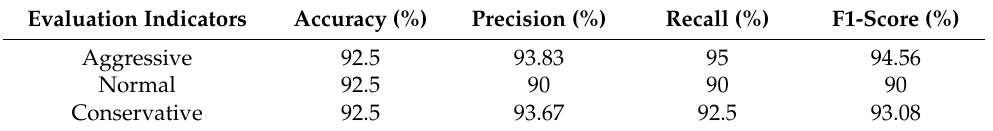
Table 14. FOA-GRNN driving propensity identification results. Table 15. Various evaluation indicators of the FOA-GRNN driving propensity identification